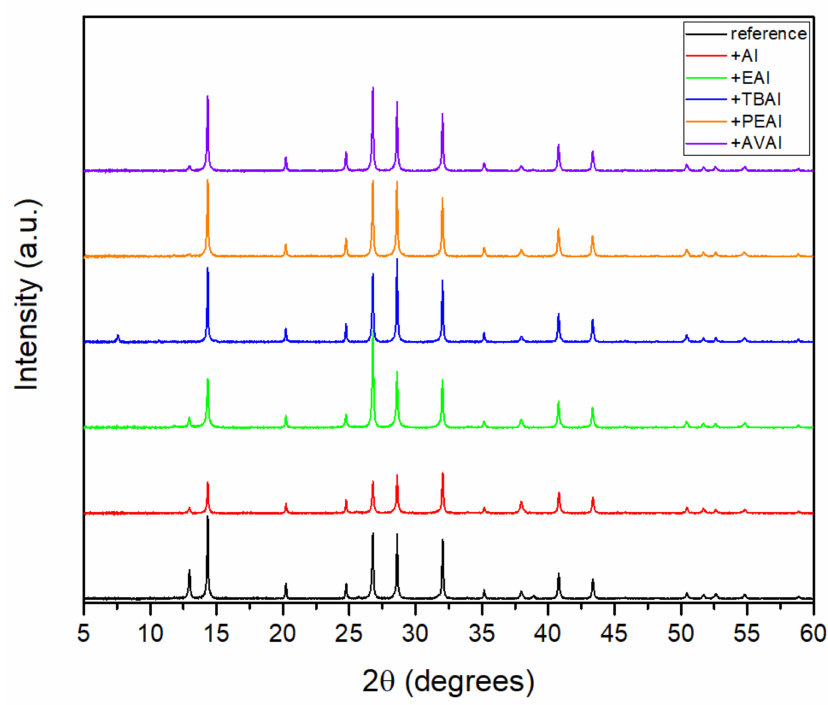
Figure 1. X-ray diffraction patterns of the perovskite films prepared without and with the ammonium iodide additives in the precursor